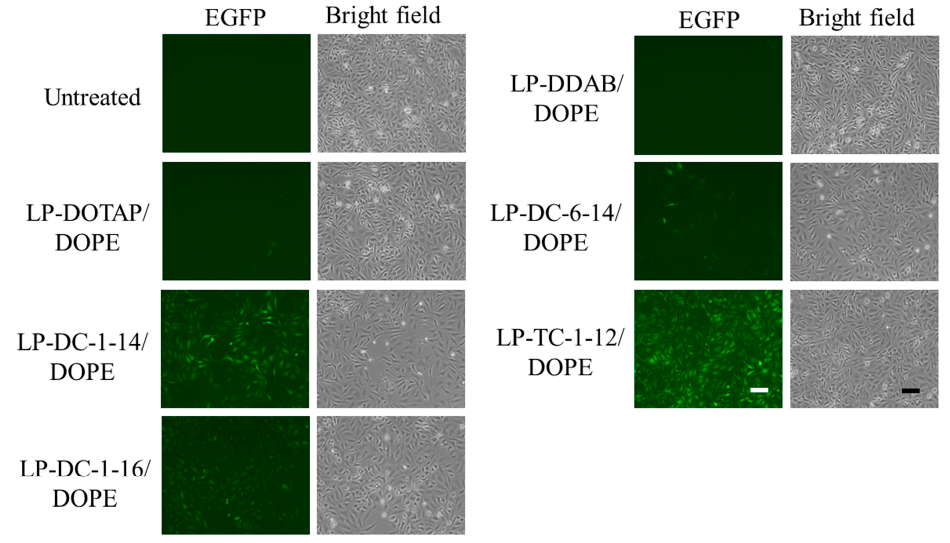
Figure 3. Effect of cationic lipids in mRNA lipoplexes on EGFP expression in HeLa cells after transfection with EGFP mRNA lipoplexes. mRNA lipoplexes with EGFP mRNA were added to HeLa cells at 0.5 µg/mL mRNA, and EGFP expression (green) was observed 24 h after incubation. Scale bar = 100 µm. EGFP: enhanced green fl uorescent protein.